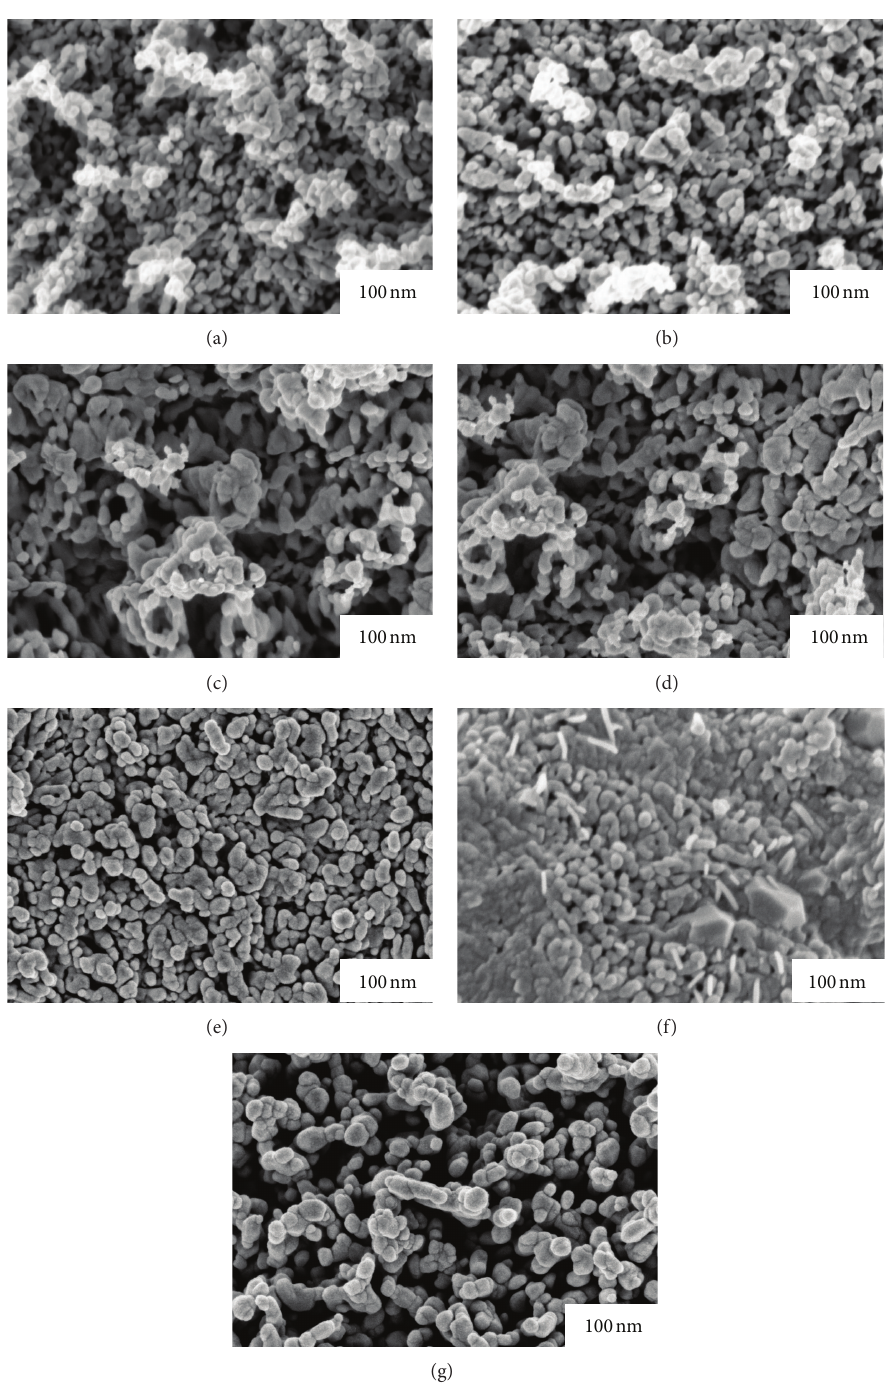
Figure 3: SEM analysis on Ca 𝑥 Zn (1−𝑥) Al 2 O 4 thin